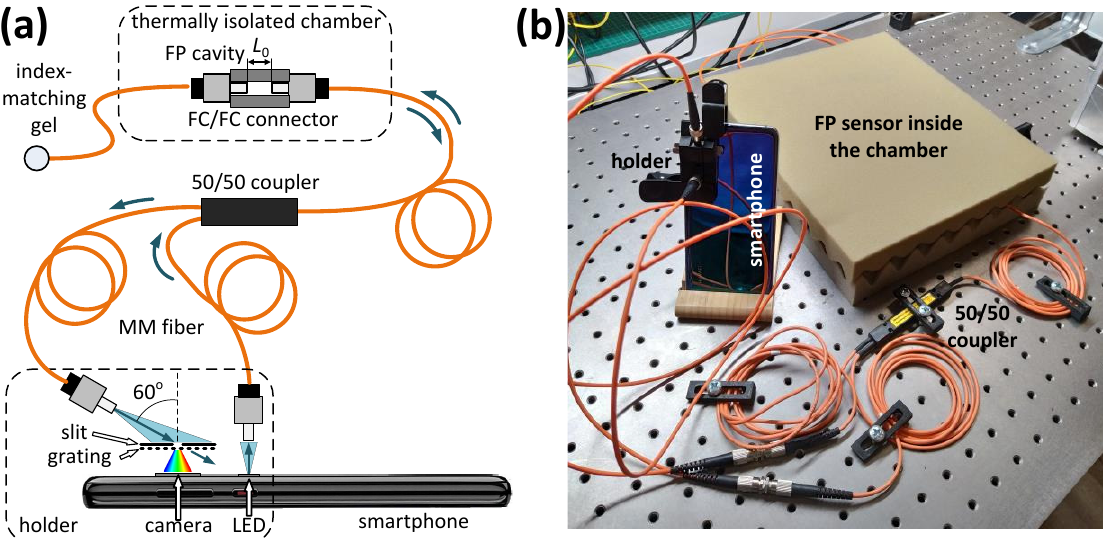
Figure 1. The schematic overview ( a ) and the photograph ( b ) of the developed smartphone-based spectrometer and its application for optical fiber Fabry-Perot interferometric sensor